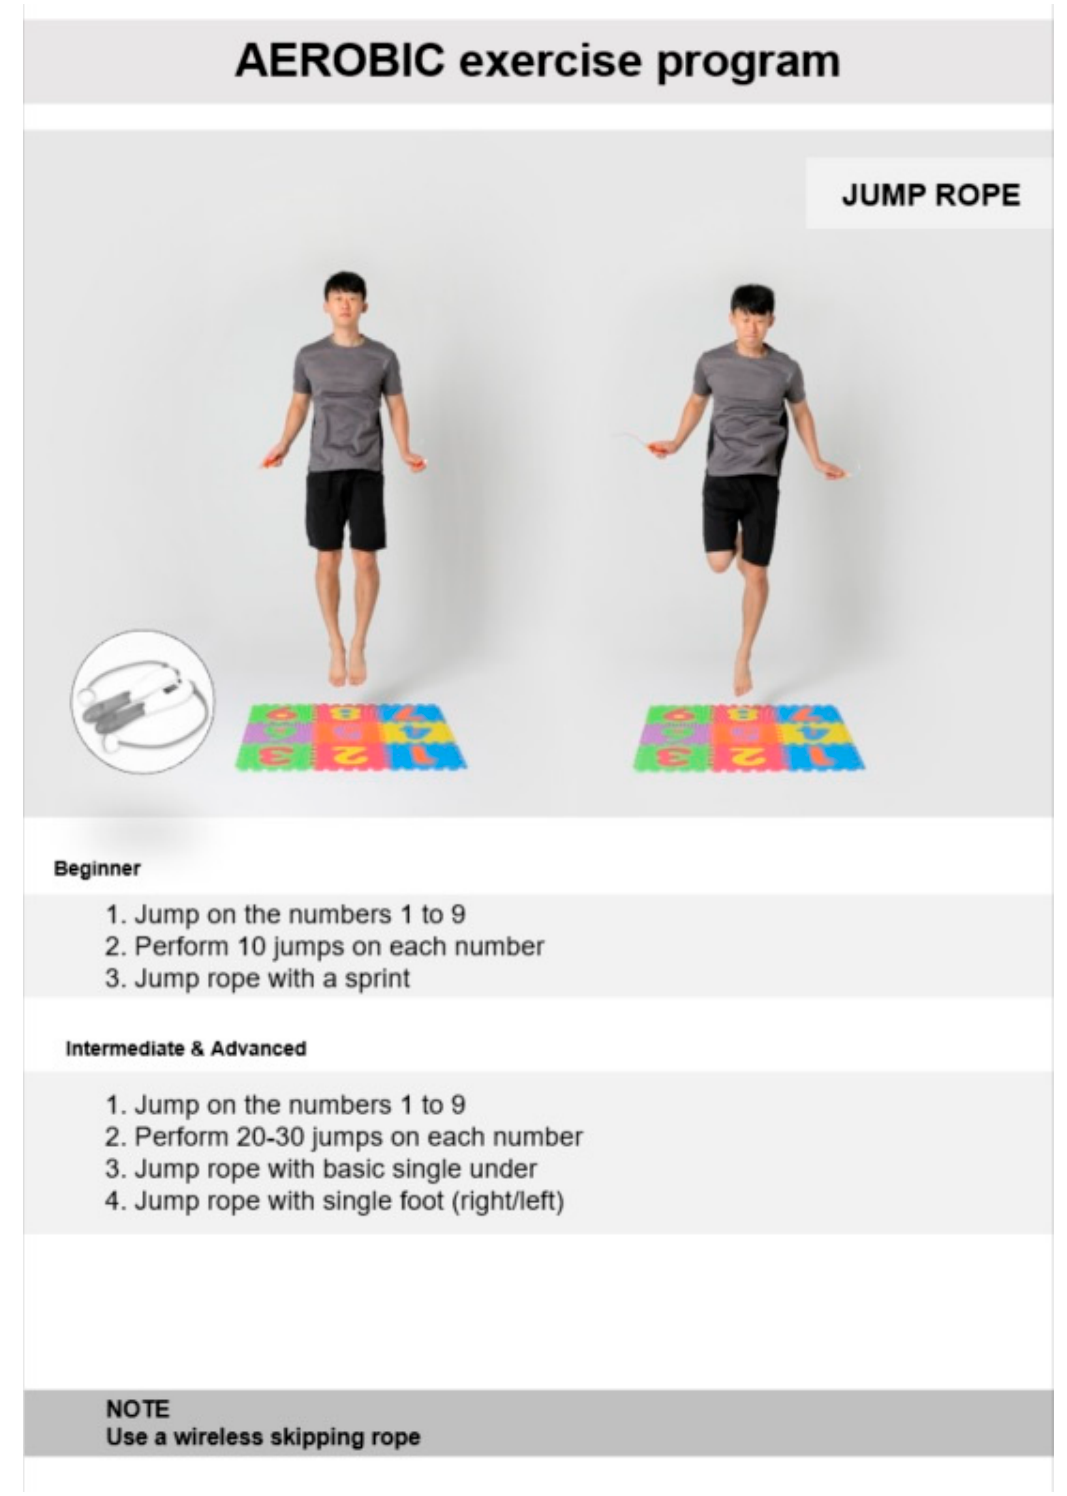
Figure A8. Detailed description and components of each movement in the “Jump rope” aerobic exercise.